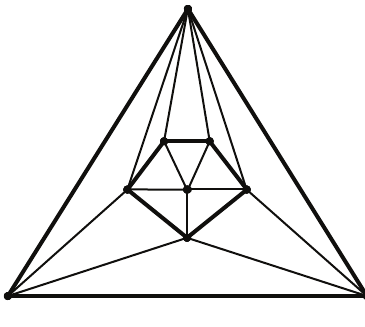
Figure 7. This 4-connected triangulation of order 9 is likely the key to why a minimum counterexample to the 4-color theorem does not exist. The Birkhoff diamond of order 10 results when the topmost vertex is split into two vertices, each of degree